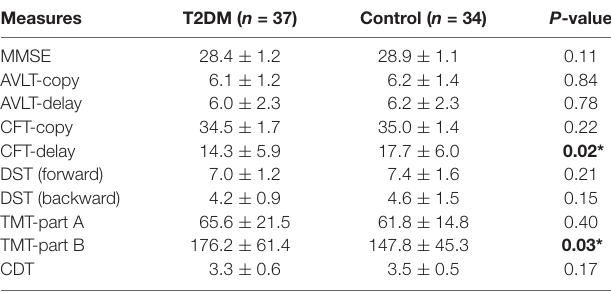
TABLE 2 | Cognitive performance of Type 2 diabetes (T2DM) and control groups. Measures T2DM ( n = 37) P -value